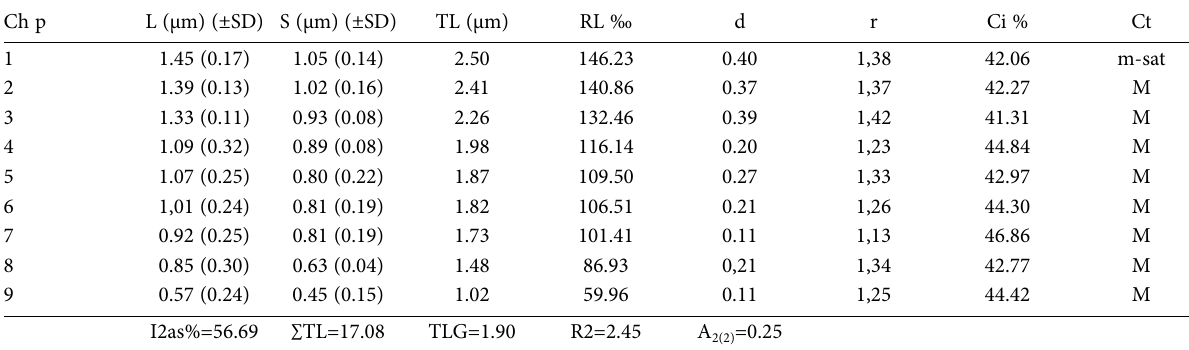
Table 3. Morphometric data within the population 23/10 (2n=18) of Trifolium subterraneum L. in Algeria.